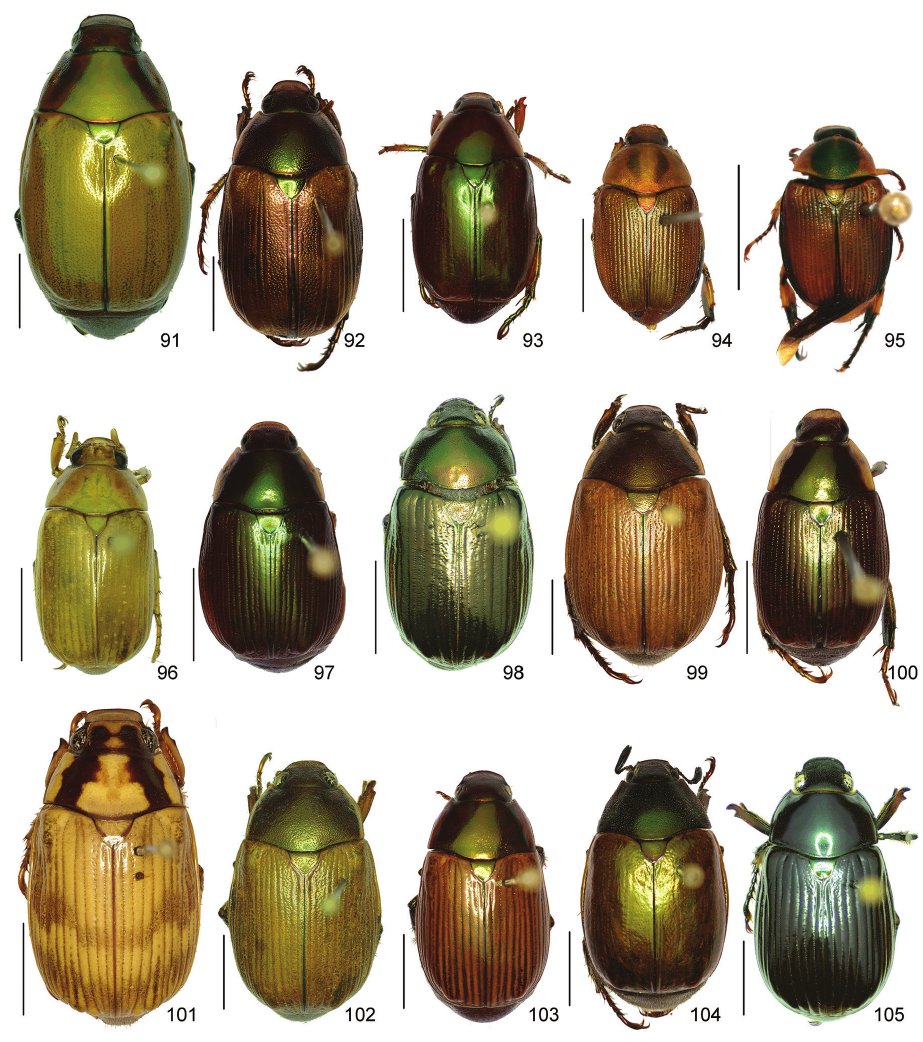
Figures 91–105. Habitus. 91 Callistethus jordani (Estación Cacao, Guanacaste, MNCR) 92 C. lativittis (Río San Lorenzo, Guanacaste, MNCR) 93 C. levigatus (Quebrada Segunda, Cartago, MNCR) 94 C. macroxantholeus (Estación Pitilla, Guanacaste, MNCR) 95 C. microxantholeus (Est. Pitilla, Guanacaste, MNCR) 96 C. mimeloides (La Montura, San José, CEUA) 97 C. multiplicatus (Sector Cerro Cocori, Limón, MNCR) 98 C. nicoya (Estación Quebrada Bonita, Puntarenas, MNCR) 99 C. parapulcher (Es- tación Altamira, Puntarenas, MNCR) 100 C. pseudocollaris (Estación La Casona, Puntarenas, MNCR) 101 C. ruteloides (holotype) 102 C. schneideri ( Estación Pitilla, Guanacaste, MNCR) 103 C.specularis (Rio San Lorenzo, Guanacaste, MNCR) 104 C. stannibractea (Estación Barva, Heredia, MNCR) 105 C. sulcans (Reserva Biológica Hitoy Cerere, Limón). Scale bars: 5 mm. Figs 92–95, 97, 99–100, 103–104 from Filippini et al. (2015a); Fig. 101 from Filippini et al.